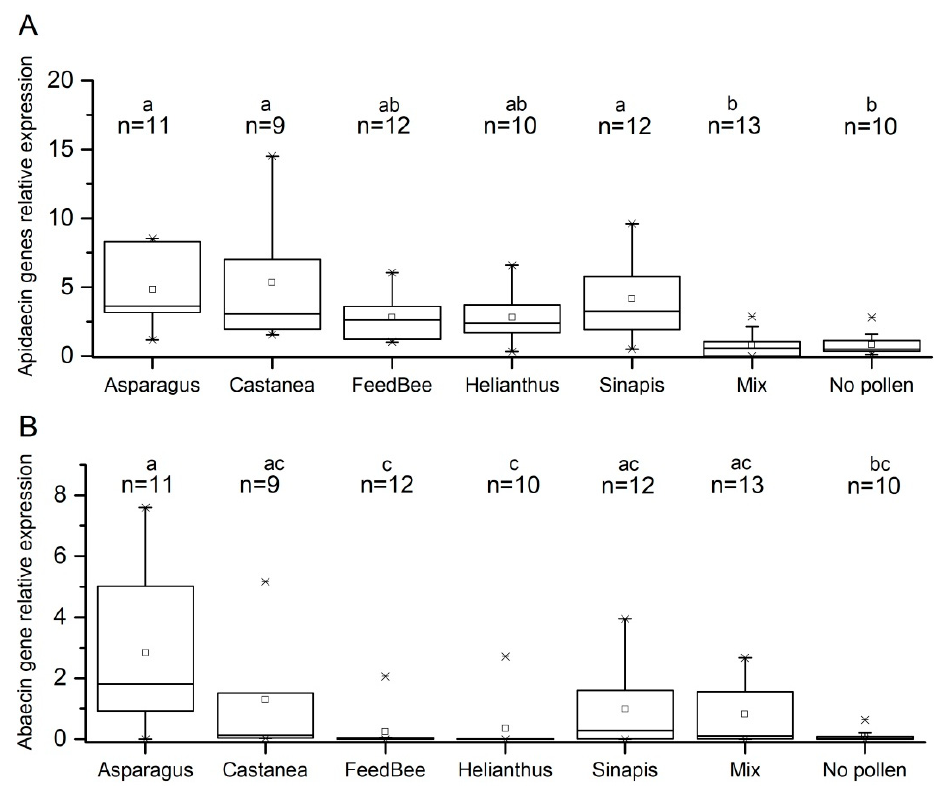
Figure 2. Relative expression of ( A ) apidaecin and ( B ) abaecin genes fed different diets. Groups are labelled by small case letters; different letters denote significant differences between groups (independent-samples Kruskal-Wallis test, p < 0.05). Boxes show first and third interquartile range with line, median is denoted. Stars represent outliers, n = number of analysed individual bees.